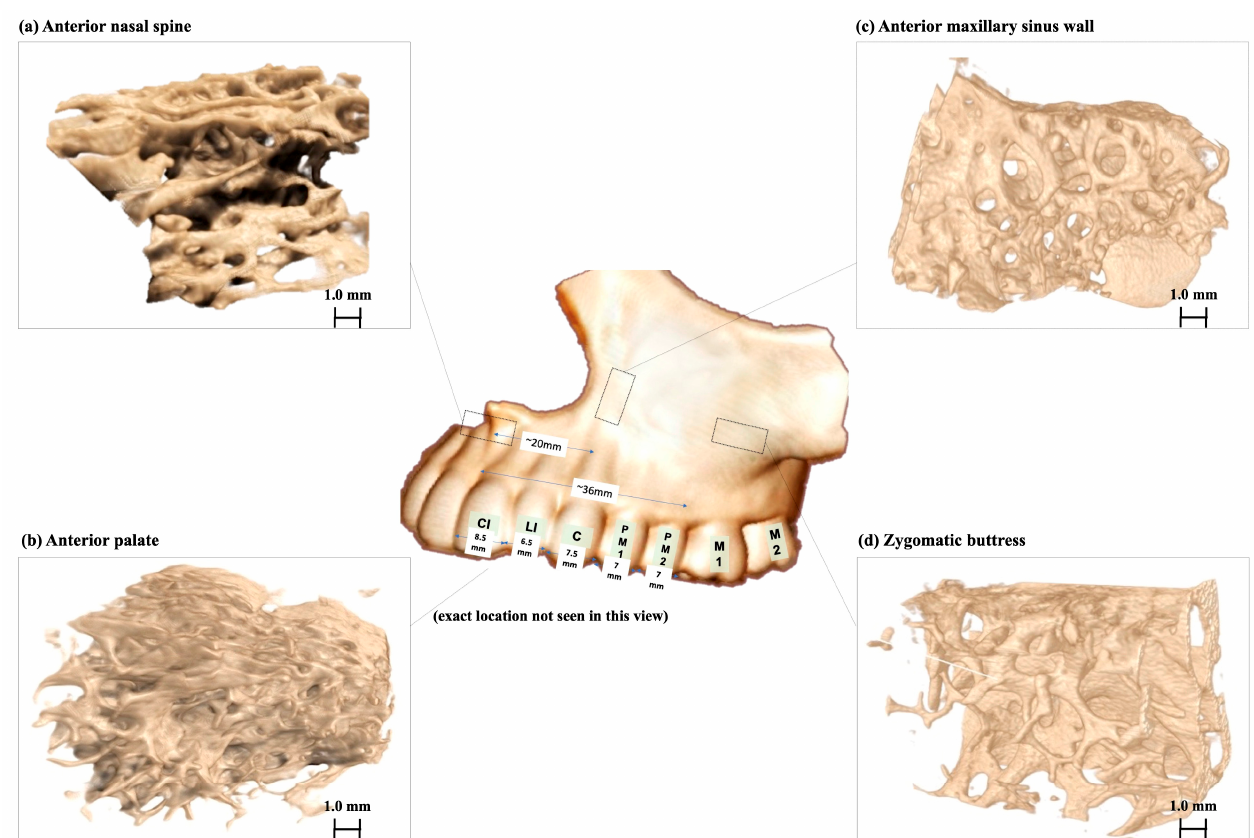
Figure 3. The reconstructed appearance of bone specimens visualised using CTvox software. ( a ) Anterior nasal spine, ( b ) anterior palate, ( c ) anterior maxillary sinus wall, ( d ) zygomatic buttress. One of the structure parameters, Tb.N, showed a value ranging from 0.71 to 1.86